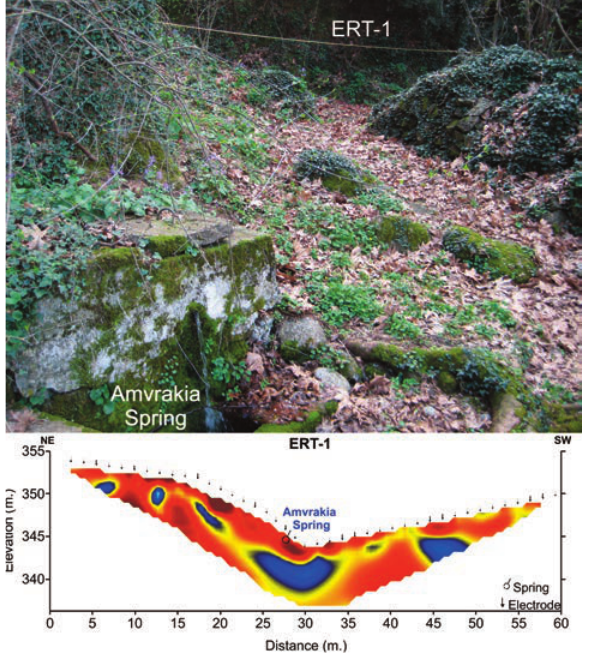
Figure 5. The first geoelectrical transverse was established uphill the spring location (above) and the interpreted tomography section, including topographic relief (below) revealed several conductive zones of relatively low resistivity values (ERT-1: 10th iteration, RMS: 2.38%). See Figure 6 for scale values.